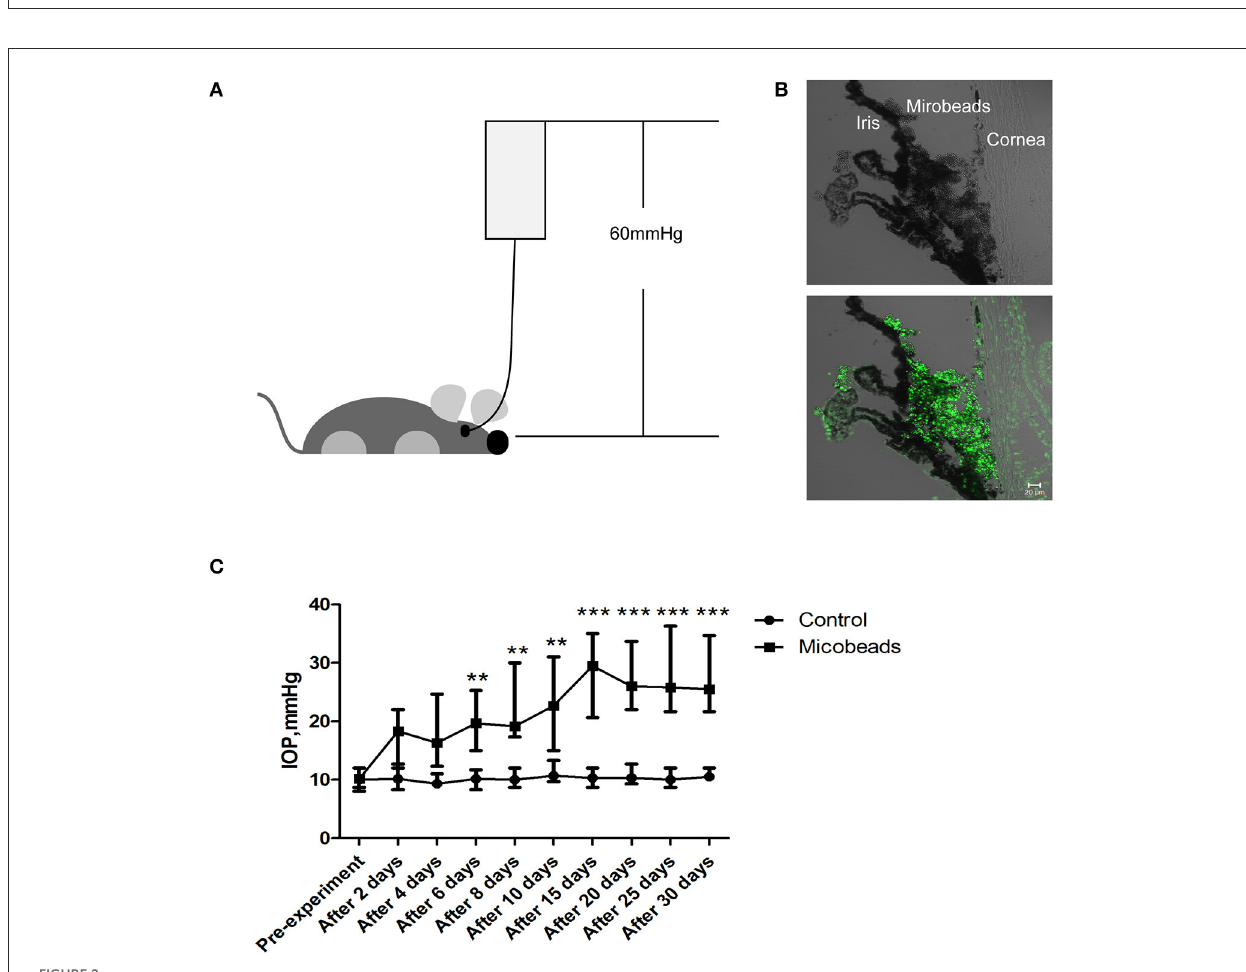
FIGURE2 Two well-established glaucoma animal models were set to mimic acute attack of APACG and chronic damage of CPACG. (A) Acute ocular hypertension model: IOP acutely increased to 60 mmHg by perfusion with normal saline into the anterior chamber, and the ocular hypertension was sustained for 2h. (B) Three-micrometer magnetic microbeads were injected into the anterior chamber angle to mimic chronic ocular hypertension. The microbeads showed autofluorescence (bottom). Scale bars: 20 µ m. (C) IOP began to increase after 2 days and reached the peak 2 weeks after the injection, IOP was measured at pre-treatment, 2, 4, 6, 8, and 10 days, and then every 5 days for 1 month after the surgery. n = 20 mice, ** P < 0.01, *** P <